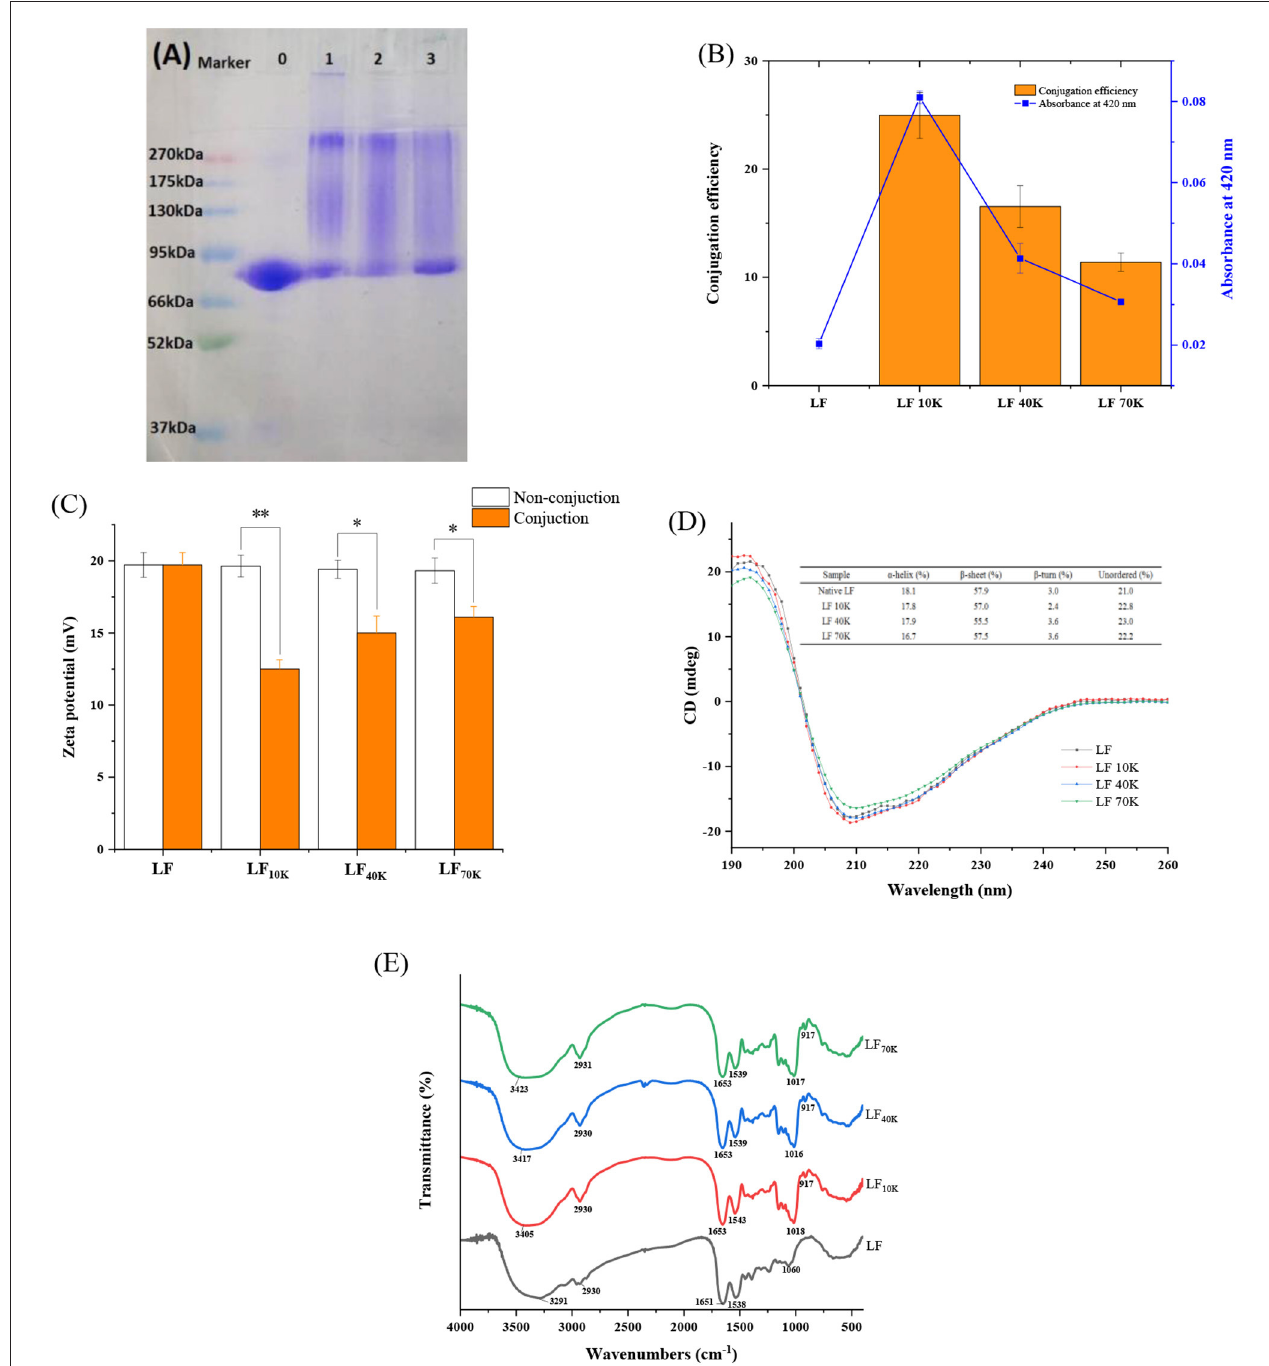
FIGURE 1 | Characterization of glycosylated lactoferrin (LF) via Maillard reaction. sodium dodecyl sulfate-polyacrylamide gel electrophoresis (SDS-PAGE) profiles, lane 0, LF; lane 1, LF 10K; lane 2, LF 40K; lane 3, LF 70K (A) . Conjugation efficiency and browning (B) . Zeta potential, non-conjunction means the mix of LF and dextran with 10, 40, or 70 kDa (C) . Circular dichroism (CD) spectra (D) . Fourier-transform infrared (FTIR) spectra (E) .